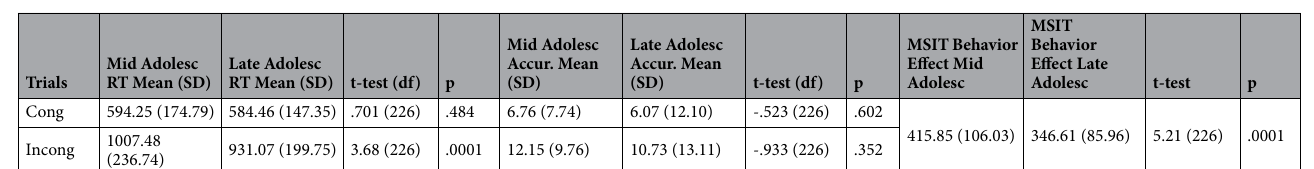
Mid Adolesc Accur.